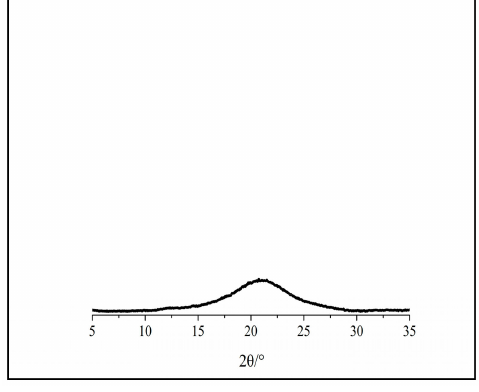
Figure 4. Patterns of amorphous cellulose. Table 1. XRD analysis of the cellulose crystallinity index ( CrI ) and crystallite size ( I hkl